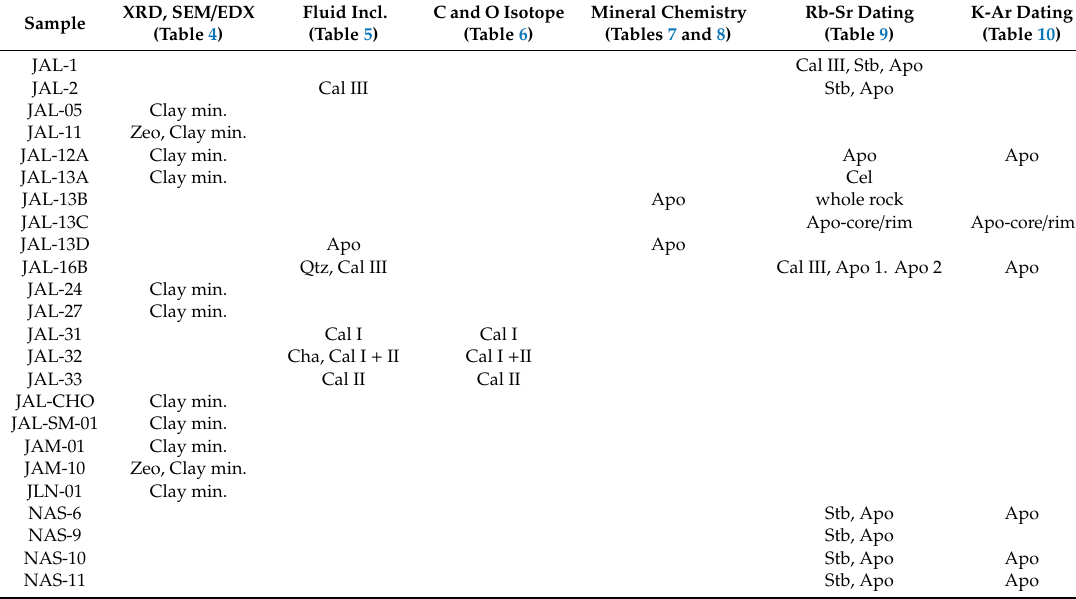
Table 3. Investigated material of the present study and applied analytical methods (Apo—apophyllite, Cal—calcite, Cel— celadonite, Qtz—quartz, Stb—stilbite, and Zeo—zeolite). XRD, SEM / EDX Fluid Incl. Sample (Table 4) (Table